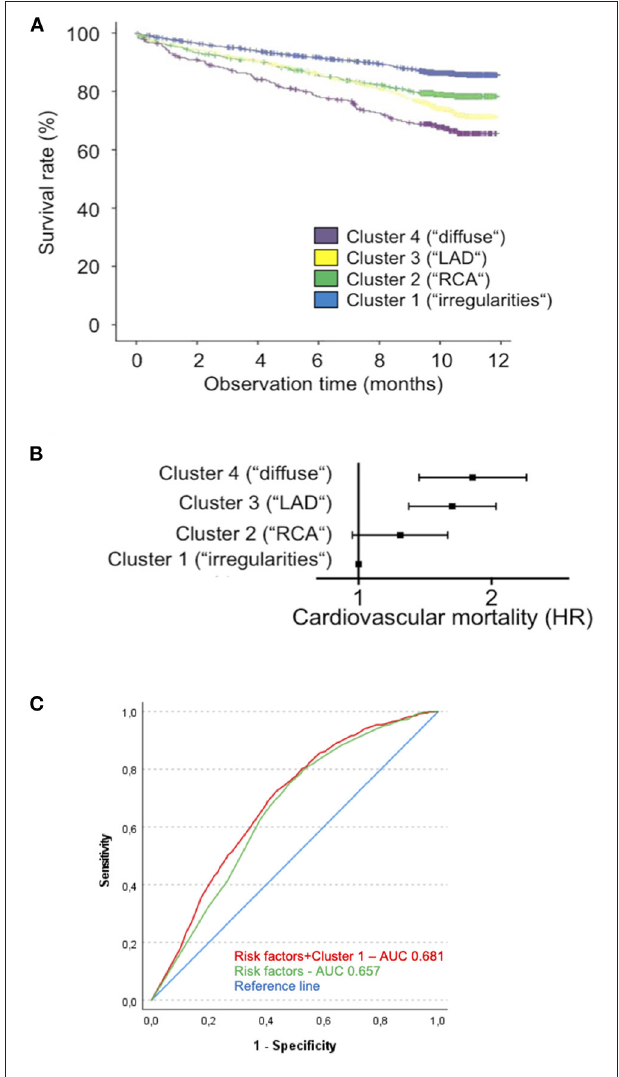
FIGURE 4 | Cluster affiliation is associated with differences in prognosis. (A) Kaplan–Meier curve for cardiovascular survival over a 12-month time period for clusters 1 (blue), 2 (green), 3 (yellow), and 4 (purple) in the LURIC cohort. (B) Forest plot indicating hazard ratios for cardiovascular death in each cluster (using cluster 1 as reference) as determined by multivariate analysis adjusted for age, gender, BMI, Diabetes, dyslipidemia, systolic blood pressure, tobacco use, family history, LV function, NT-proBNP, hs-TnT, hs-CRP, and white blood count. Cluster 2: HR = 1.242, 0.986–1.592, n.s.; cluster 3: HR =